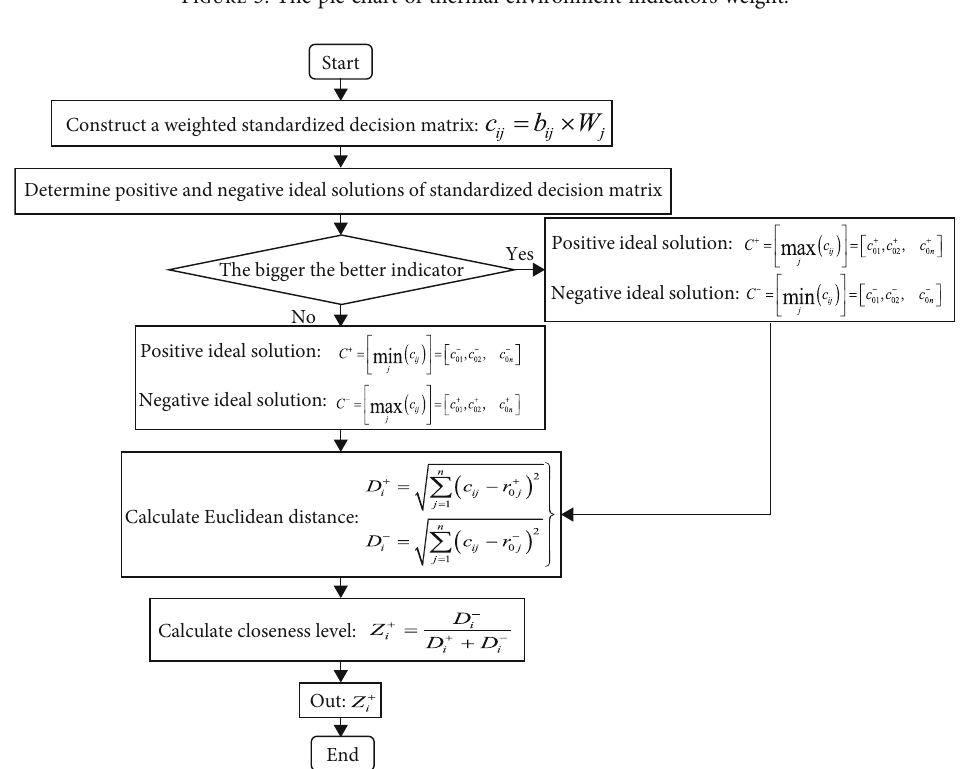
Figure 4: Stope heat damage evaluation based on entropy weight TOPSIS method process